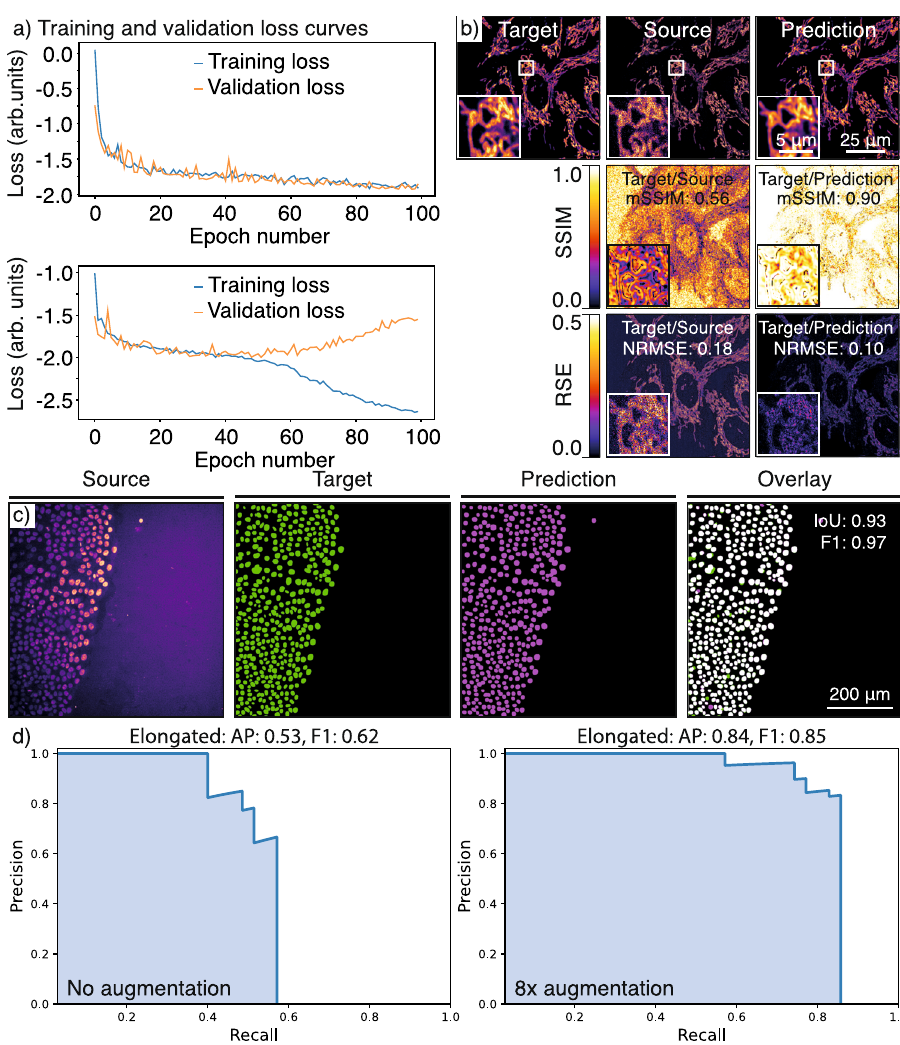
Fig. 8 Quality control of trained models. a Over fi tting models: Graphs showing training loss and validation loss curves of a CARE network with different hyperparameters. The upper panel shows a good fi t of the model to unseen (validation) data (main training parameters, number_of_epochs: